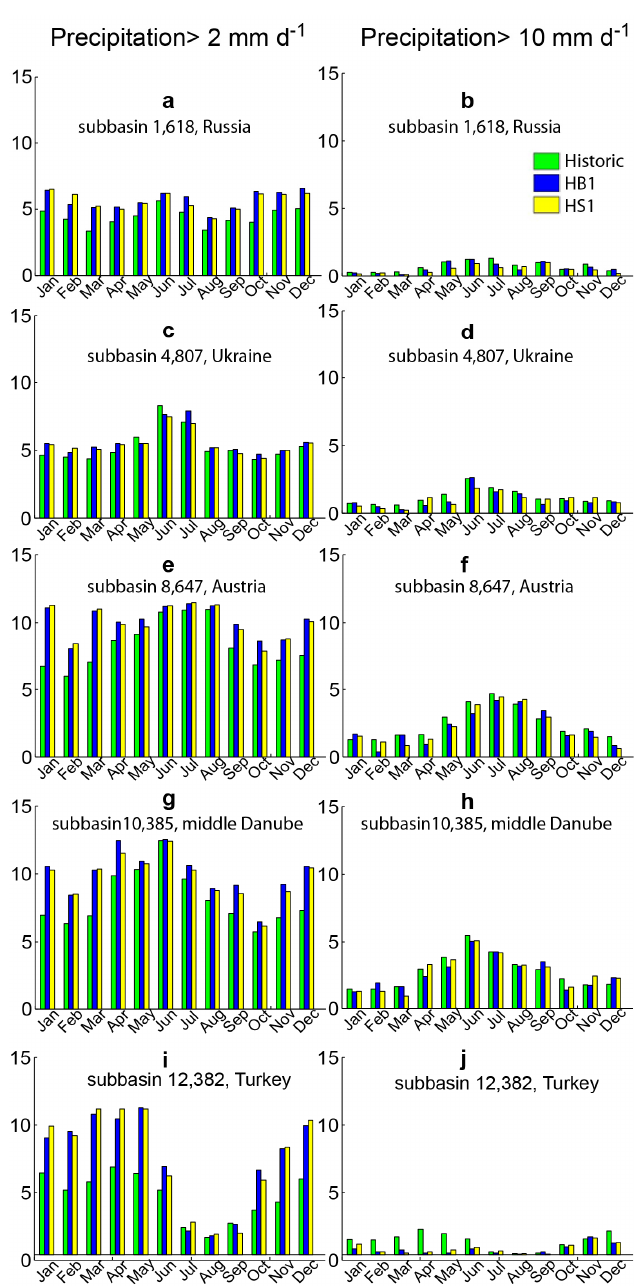
Figure 11. Comparison of the number of wet days with >2 mm d − 1 threshold ( left column ), and >10 mm d − 1 threshold ( right column ) between the historic (1973–2006) and HB and HS future climate scenarios (2020–2050) for five selected sub-basins ( a,b ) a subbasin in Russia; ( c,d ) a subbasin in Ukraine; ( e,f ) a subbasin in Austria; ( g,h ) a subbasin in middle Danube; and ( i,j ) a subbasin in